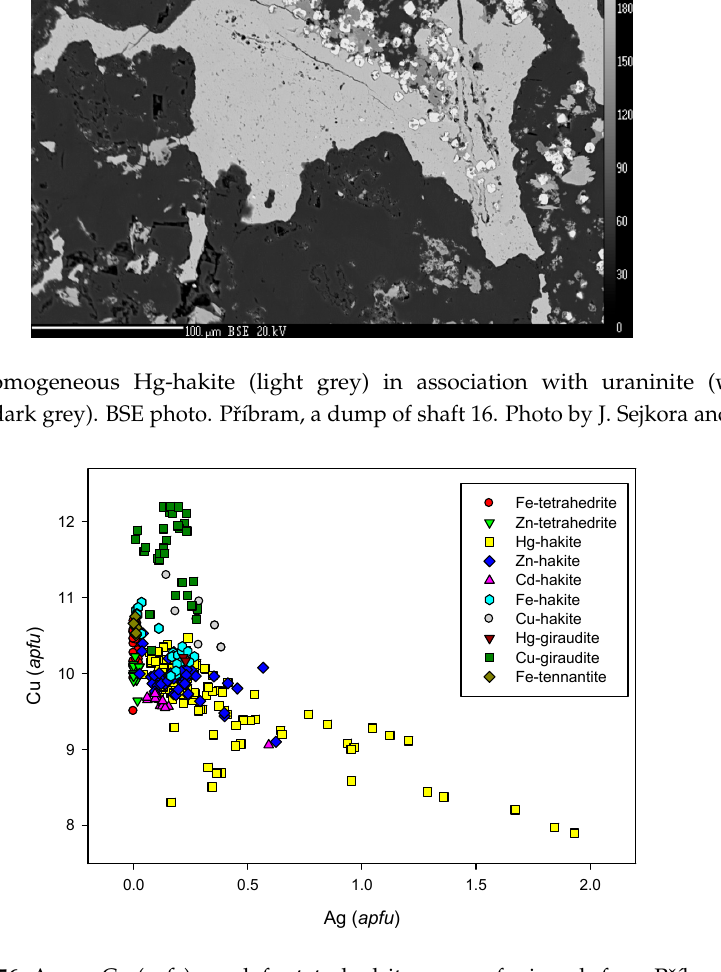
Figure 56. Ag vs. Cu ( apfu ) graph for tetrahedrite group of minerals from P ř íbram.